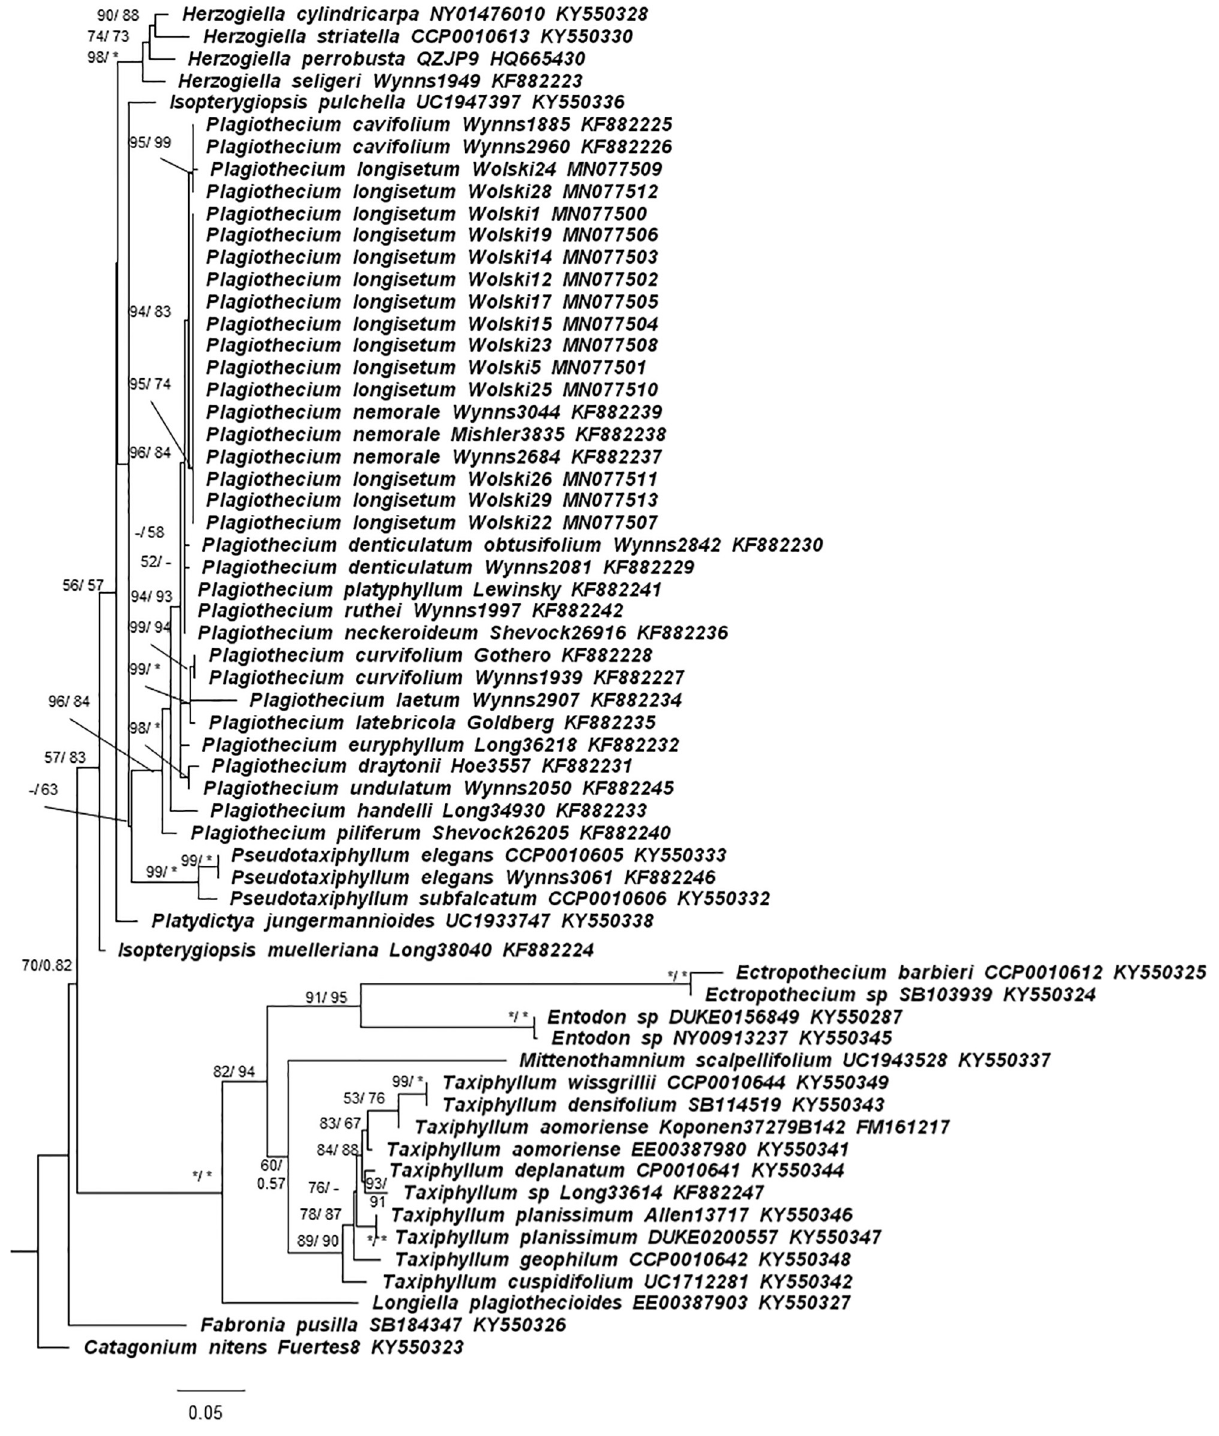
Fig 4. Phylogenetic tree based on ITS sequences (total 710 bp) showing the position of P . longisetum specimens among other Plagiothecium and similar hypnalean mosses. Numbers on branches indicate bootstrap values from ML followed by posterior probabilities from BI analysis. Asterisk ( � ) indicates 100 (ML) and 1.00 (BI), while minus (-) indicates values below 50 (ML, BI). The topology of the tree was based on ML analysis.